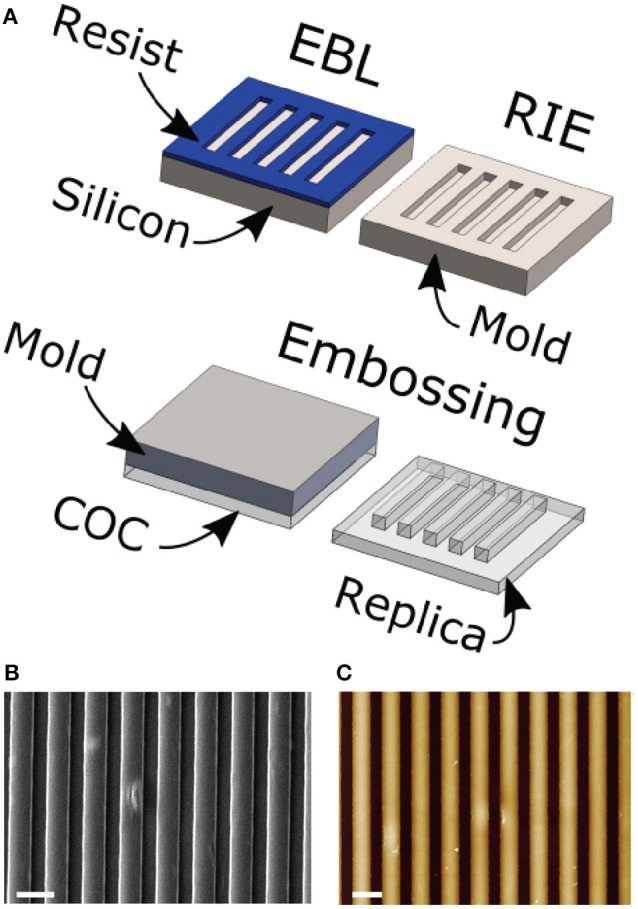
(A) Scheme of the substrate fabrication process. COC foils are placed on nano/microstructured molds and imprinted following a single heating and pressure cycle. Scanning electron microscope (B) and atomic force microscope (C) representative images of a T2 substrate. Scale bars = 2 um; The color-scale in (C) goes from 0 (black) to 400 nm (white).